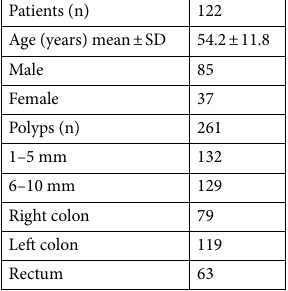
Table 1. Clinical